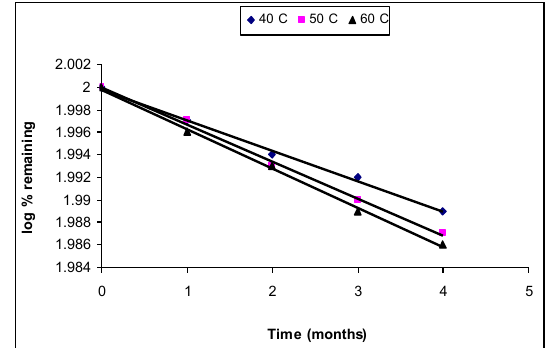
Figure (1): Degradation curve of frusemide oral solution (formula I) at 40, 50, 60 0 C